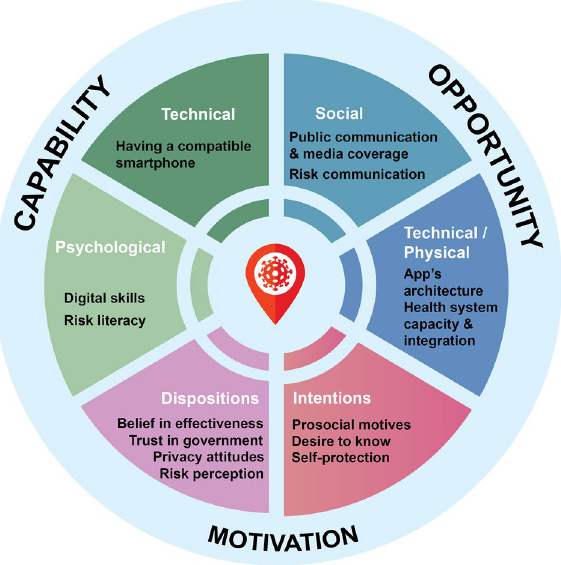
Figure 12. Behavioral framework for digital contact tracing. Adapted from the behavior change wheel 28